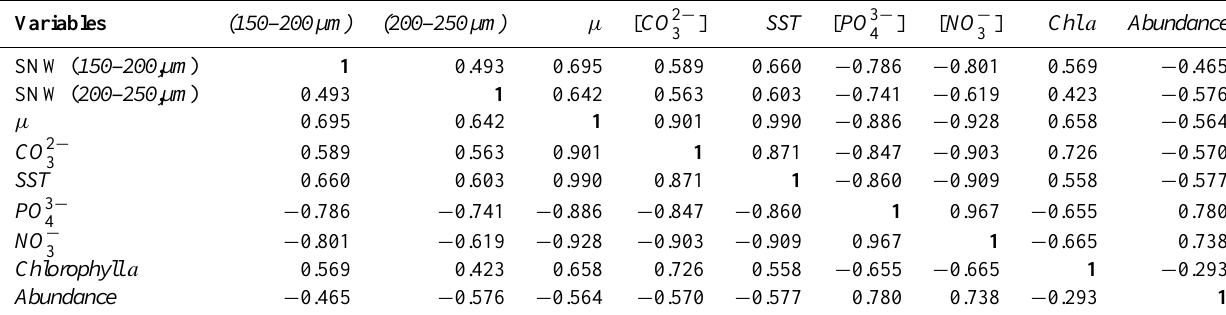
Fig. 2. The mean sieve-based weight (SBW; µ g) and measurement-based weight (MBW; µ g) versus the mean diameter ( µ m) for G. bulloides from 150–200µm (A,B) and 200–250µm (C, D) size-fractions. Dashed lines represent relationships that are statistically significant at the 95% confidence level. Table 3. Correlation matrix of parameters measured (test masses and environmental